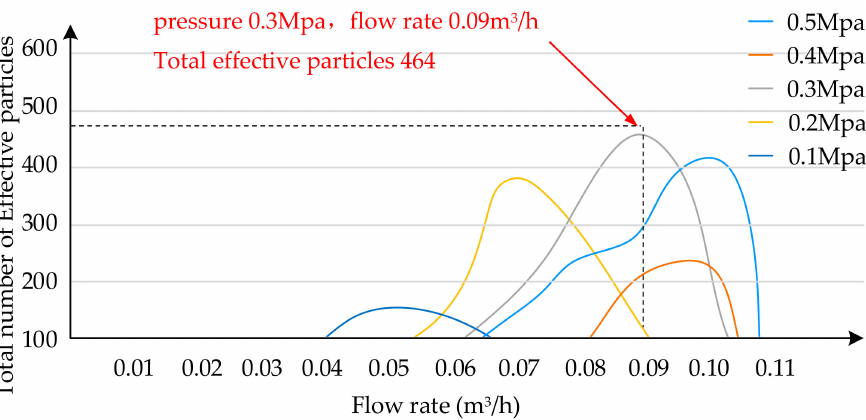
Figure 11. Total e ff ective droplets at each flow rate at 0.5 Mpa, 0.4 Mpa, 0.3 Mpa, 0.2 Mpa and 0.1